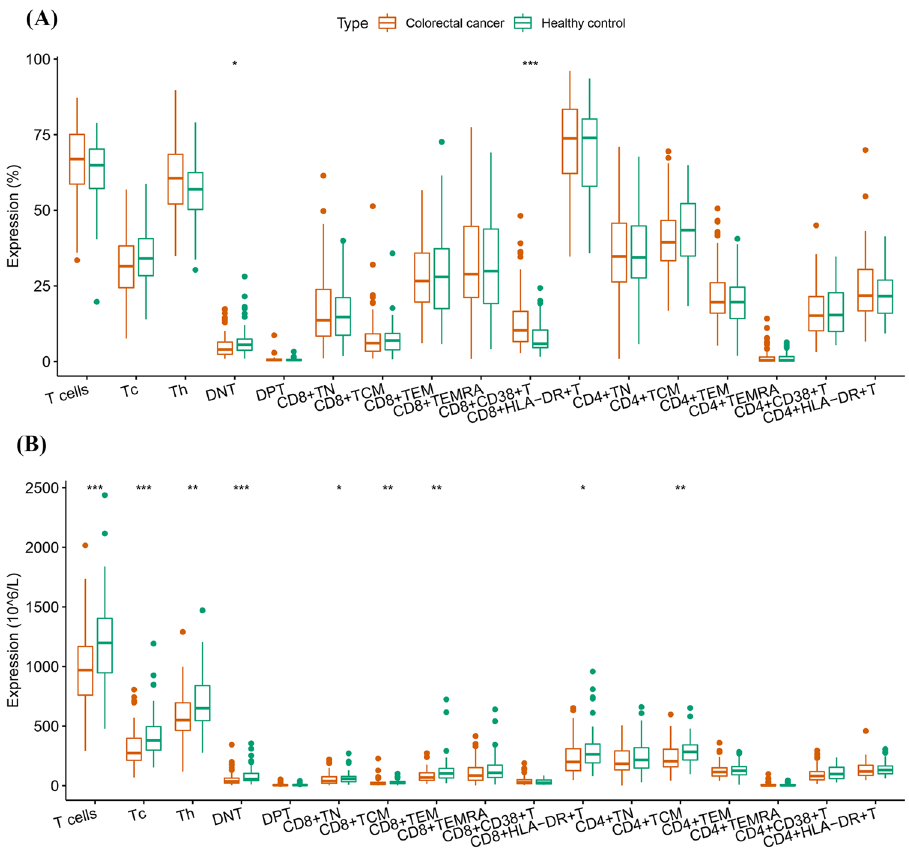
Figure 1. Differences in T lymphocyte subsets between the healthy control and CRC groups. ( A ) Proportions of T lymphocyte subsets. ( B ) Absolute counts of T lymphocyte subsets.